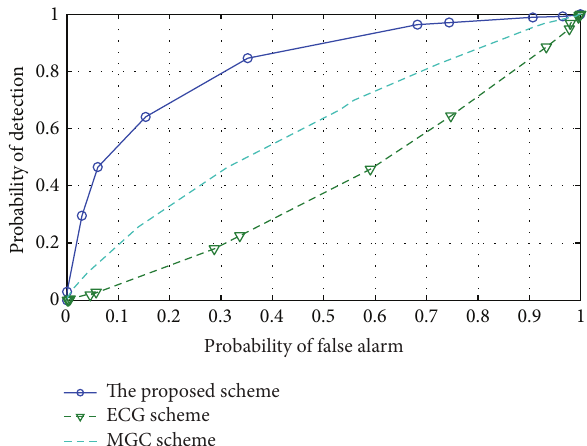
Figure5:ROCoftheproposedschemeandreferenceschemeswhen 4 opposite malicious CUs are